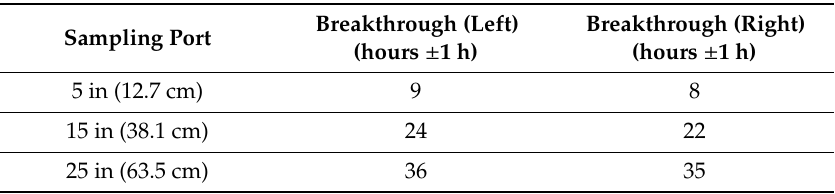
Table 3. Breakthrough times for Legionella